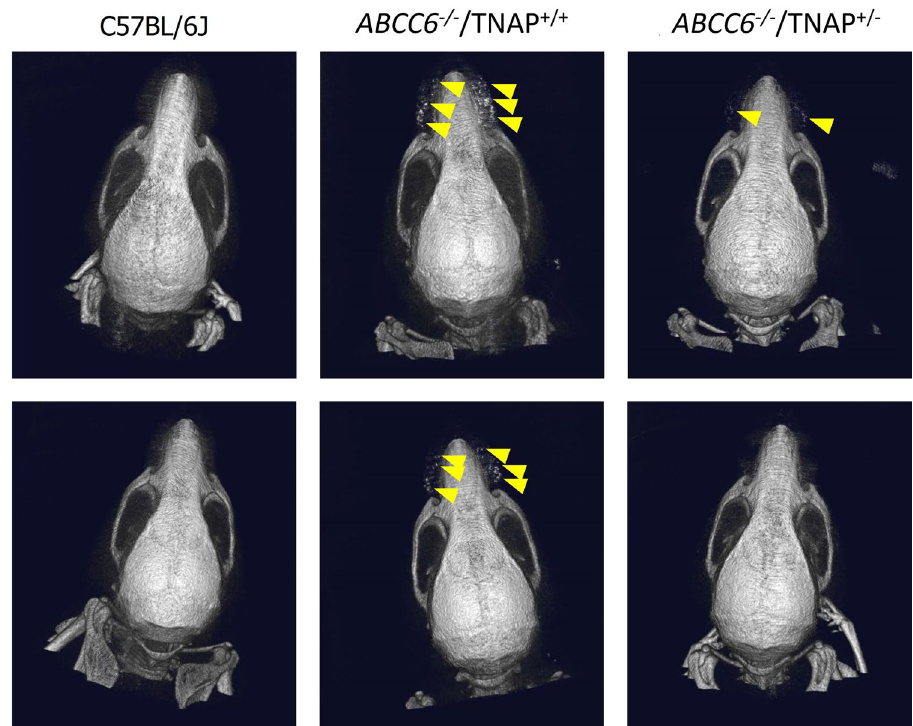
Figure 5. Microcomputed tomography imaging showing calcification of vibrissae in ABCC6 -/- /TNAP +/+ mice, ABCC6 -/- /TNAP +/- mice, and control C57BL/6J mice after the acceleration diet. Representative images from two mice in each group are shown. Yellow arrows indicate calcium deposition. TNAP, tissue-nonspecific alkaline phosphatase.